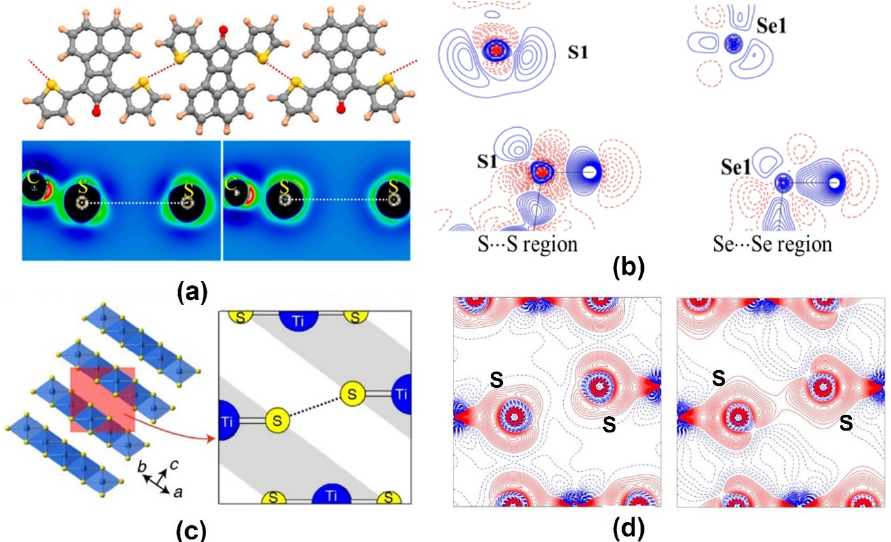
Figure 7. ( a , b ) S ··· S and Se ··· Se homo-chalcogen interactions explored using charge density multipole modeling (CDMM) method in a series of crystal structures. ( c ) Layered structure of TiS 2 showing interlayer S ··· S interaction. ( d ) Theoretical (left) versus experimental (right) deformation density maps for the interlayer S ··· S interaction region—the overlapping density in the experimental map is notable. (Figures reproduced from references [55–57] ).